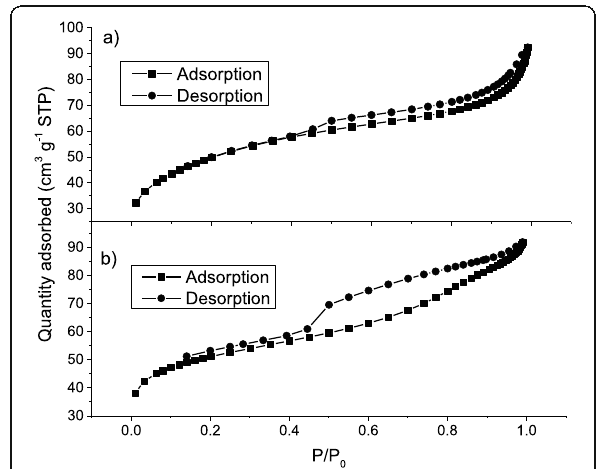
Fig. 2 Adsorption and desorption curves of a CCF and b